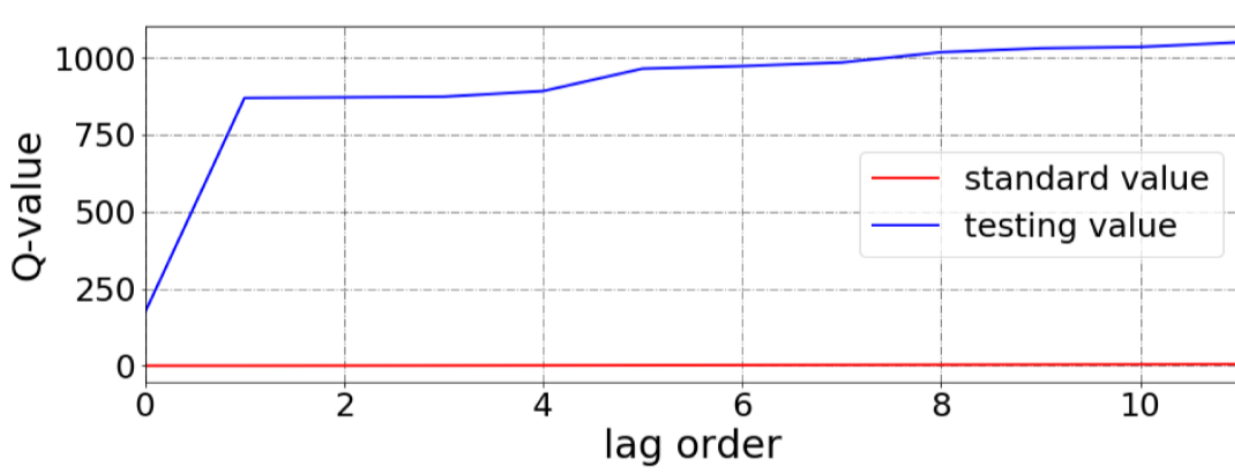
Figure 5. Box_Ljung value of each lag order.